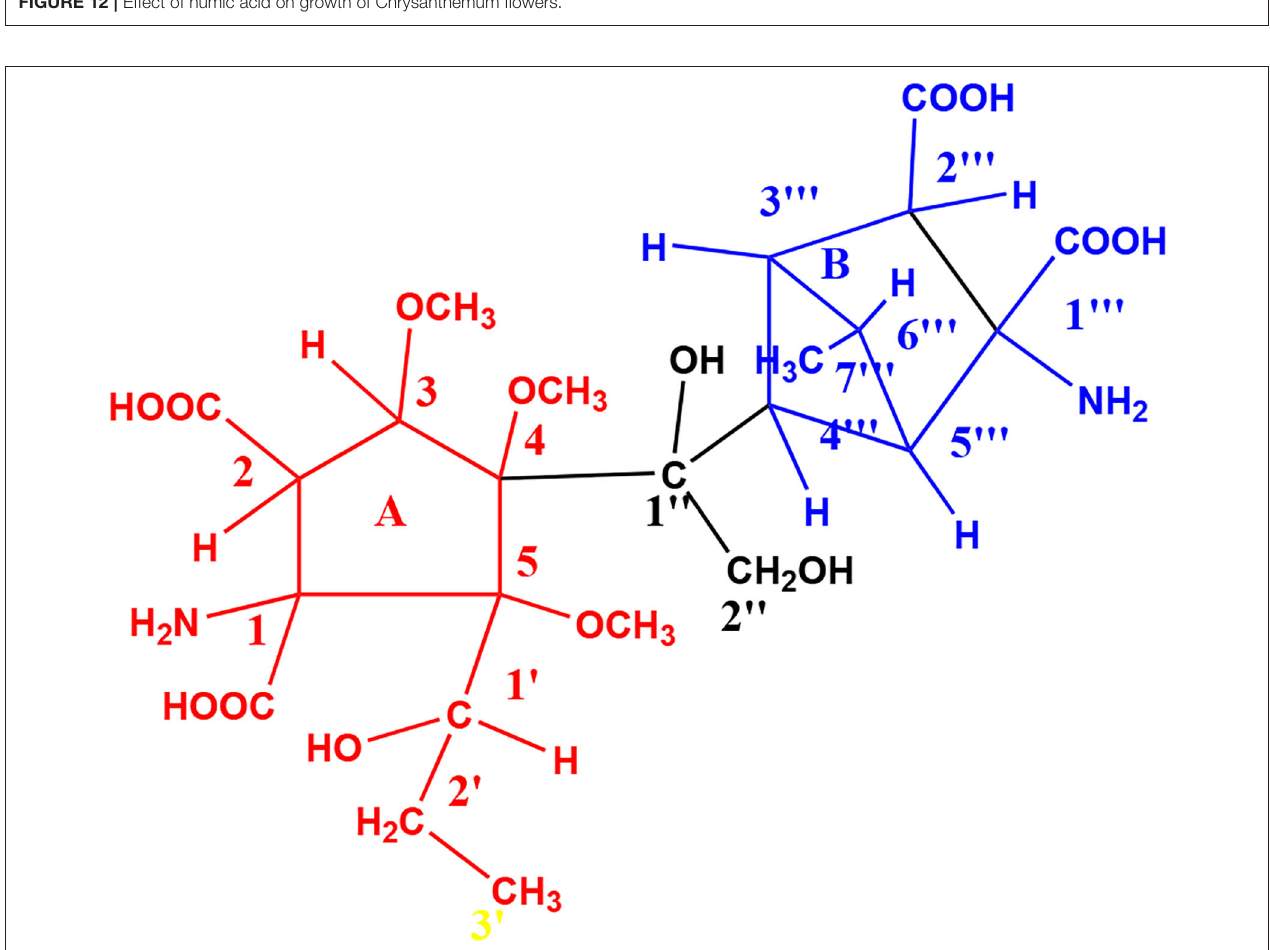
FIGURE 13 | Proposed structure of “Gwal Pahari